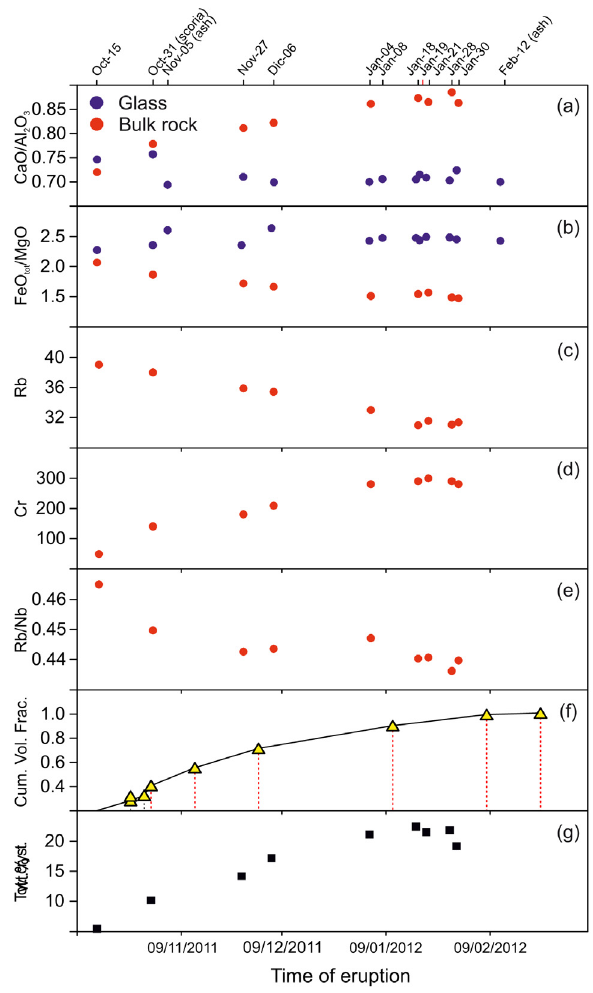
O and (b) FeO /MgO versus time for bulk Figure 10. (a) CaO/Al 2 3 tot rocks (red circles) and glasses (blue circles) composition. (c-e) Tem- poral variation diagrams of (c) Rb, (d) Cr and (e) Rb/Nb ratio (unit in ppm). (f) cumulative volume fraction (yellow triangles) of erupted material after Rivera et al. [2013] and (g) total crystallinity (wt.%) obtained by mass balance calculation between bulk rocks and glass considering the average composition of minerals. Table 4 (left). Mean glass composition of studied products with standard deviation value and in the content of compatible elements (e.g. /MgO Cr; Figure 10d) and by the decrease in the FeO tot value (Figure 10b) and in the content of incompatible elements (e.g. Rb; Figure 10c). On the contrary, composition of glass is almost ho- mogeneous during the entire eruption (Table 4 and Fig- ure 10a and b), and approximates the composition of bulk rocks erupted during the first two weeks of erup- tion (samples of October 15 and 31, 2011). Also ratio between highly incompatible elements (e.g. Rb/Nb reported in Figure 9) remains constant (within the analytical error range) during the whole eruption, this once again indicates that the magma feed- ing the eruption maintains homogeneous geochemical signature.